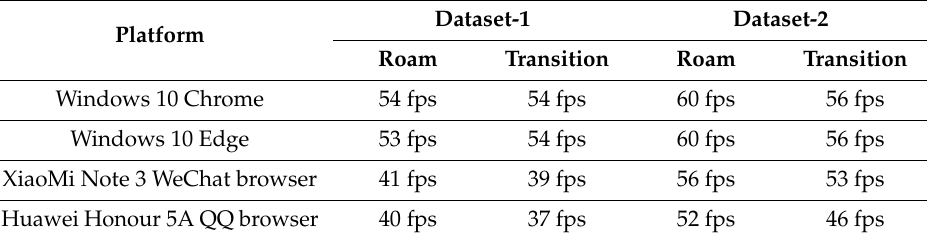
Table 4. E ffi ciency performance using di ff erent data on various browsing